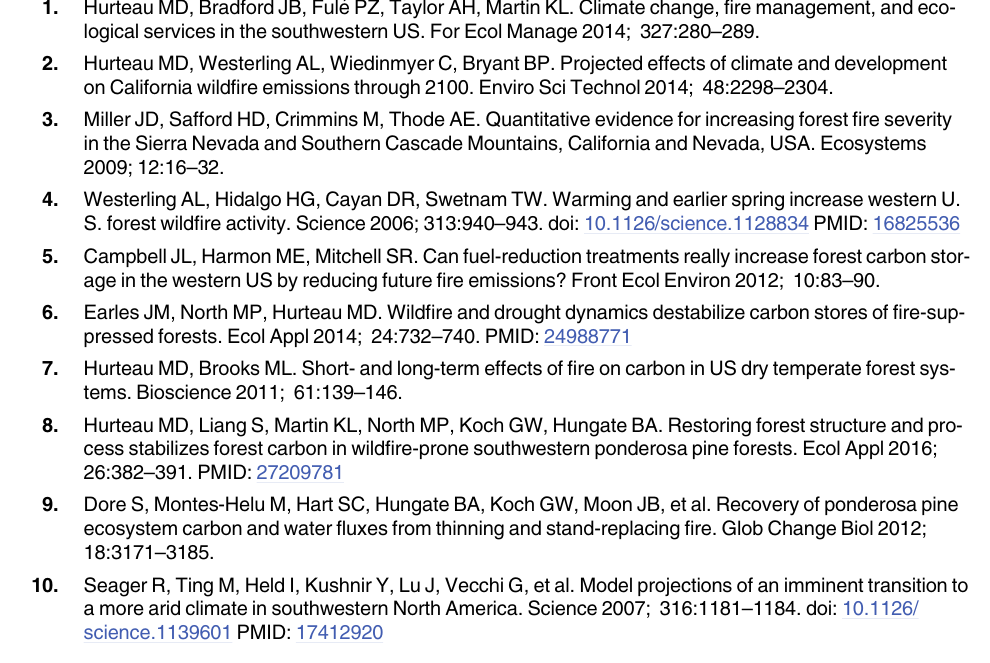
S5 Table. Comparison of seedling establishment probabilities. T-test comparison of